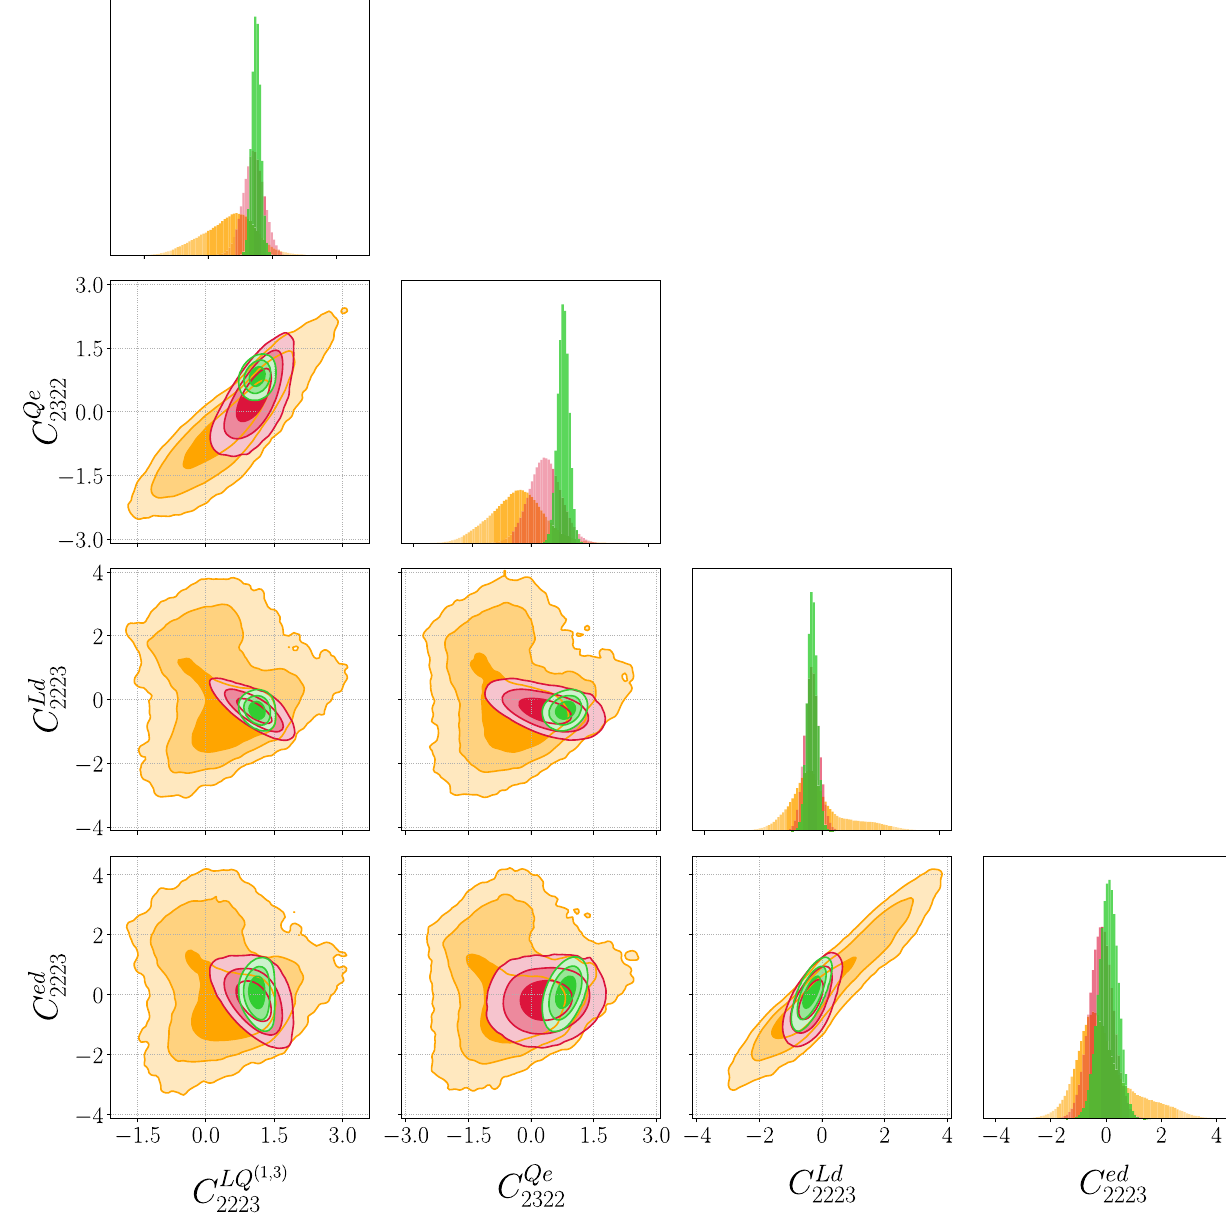
Fig. 7 Posteriors for C LQ